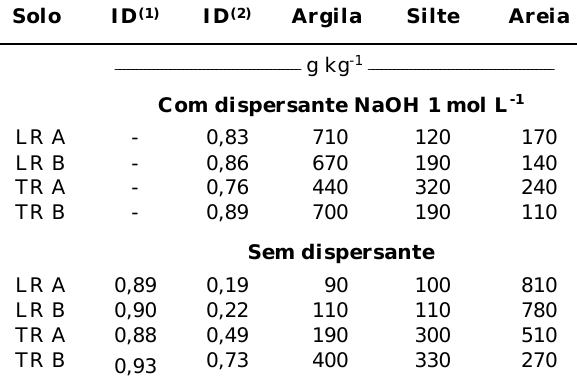
(1) ID = índice de dispersão não normalizado obtido por ultra- som a 714,8 J mL -1 . (2) ID = índice de dispersão obtido em análi- se granulométrica.